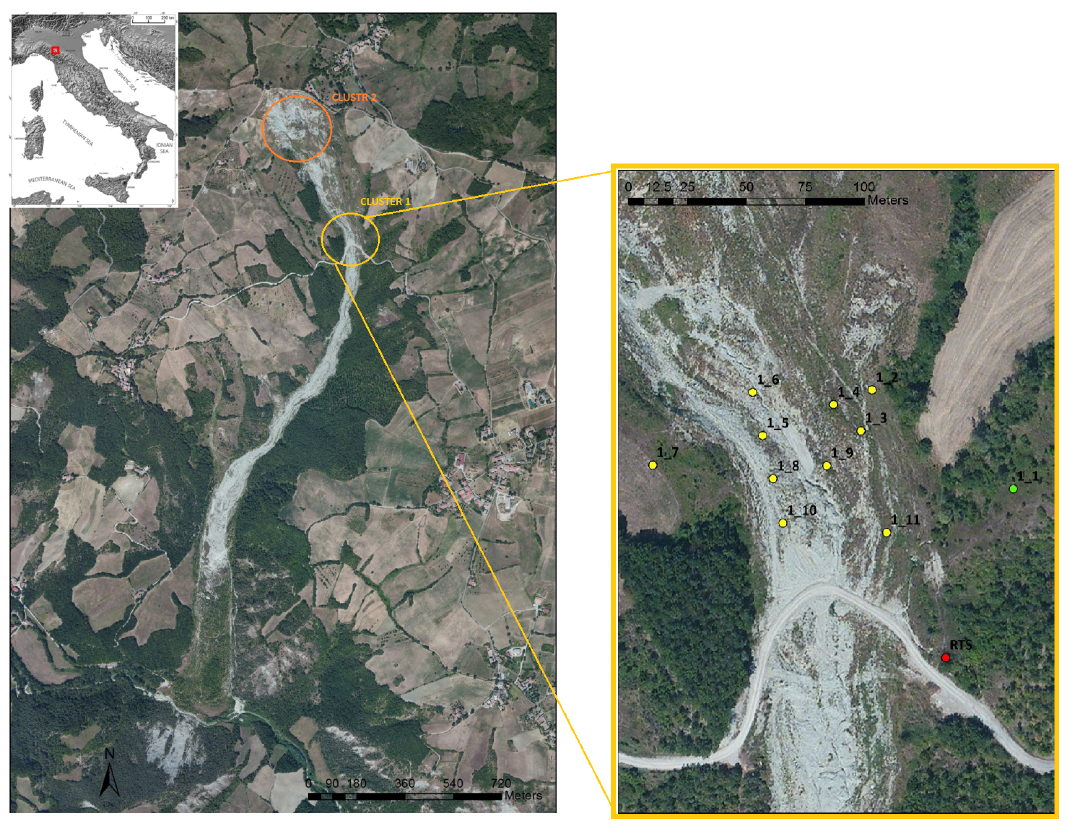
Figure 7. Aerial photograph of the Roncovetro landslide and Wi-GIM clusters. The green dot signifies a sensor which was put outside the landslide, where the terrain is supposed to be not subjected to movements. This point is also used as a reference for